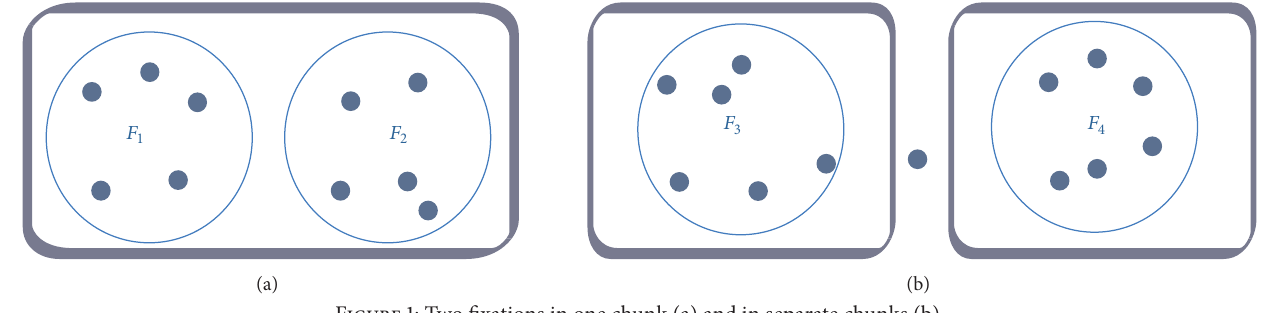
Figure 1: Two fixations in one chunk (a) and in separate chunks (b). Table 1: Pattern extraction by prefix “ 𝑎 ” at